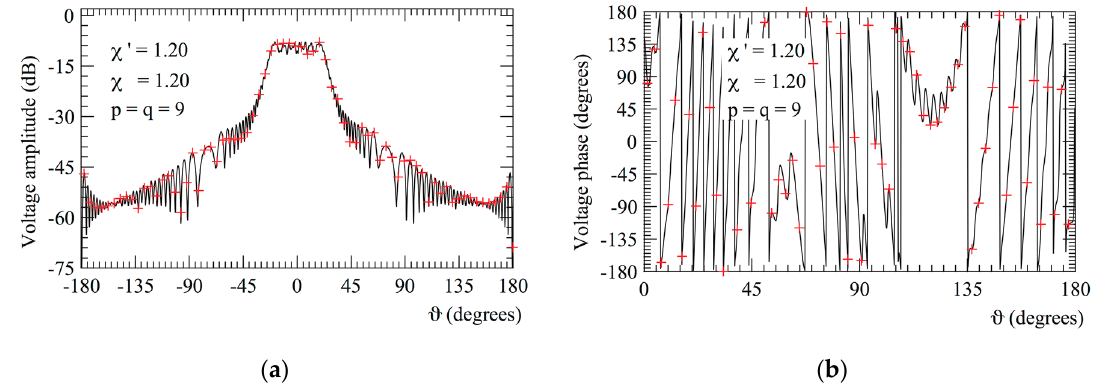
Figure 2. r V on the meridian at ϕ = 90°. ――― exact. + + + + interpolated from the non-redundant Figure 2. V r on the meridian at ϕ = 90 ◦ .—exact. + + ++ interpolated from the non-redundant samples: ( a ) amplitude; ( b ) phase. samples: ( a ) amplitude; ( b ) phase.